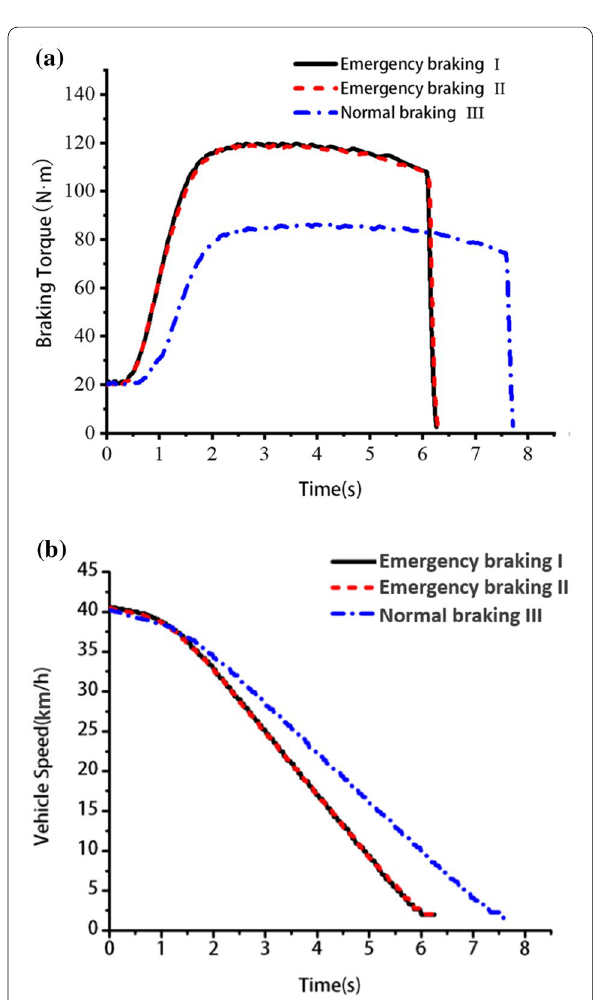
Figure 16 Changes in ( a ) the braking torque of the MR brake and ( b ) the vehicle speed during braking